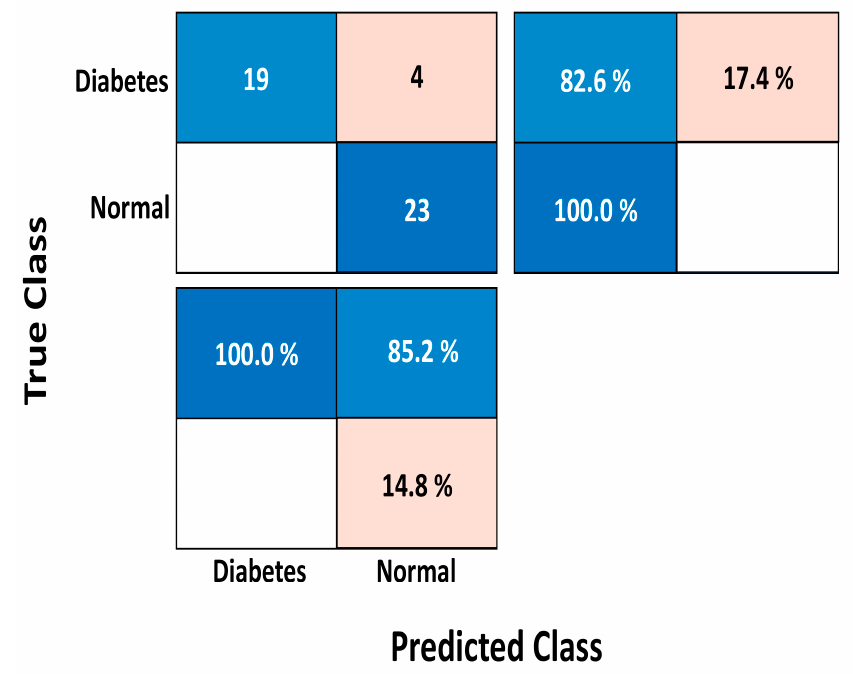
Figure 18. Confusion matrix for super vector machine with testing accuracy: 91.30%.